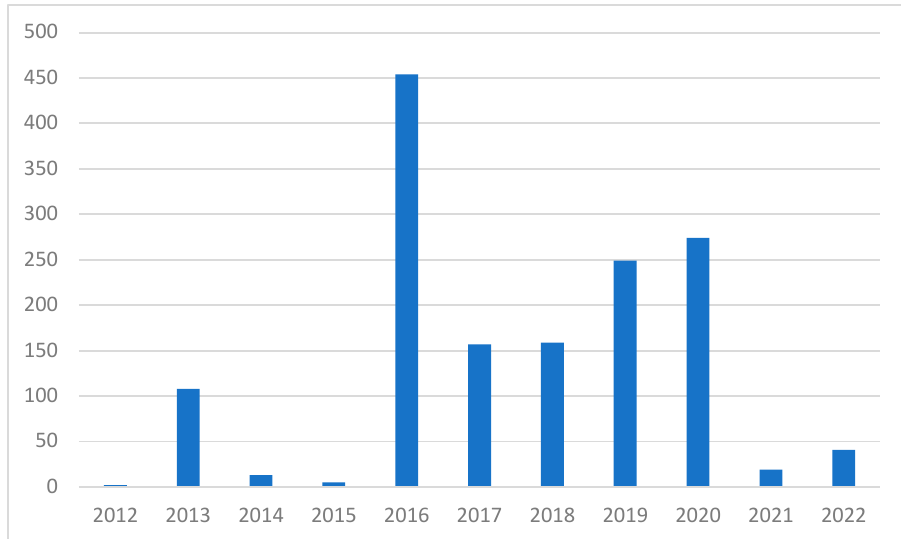
Figure 6. Number of studies year-wise.